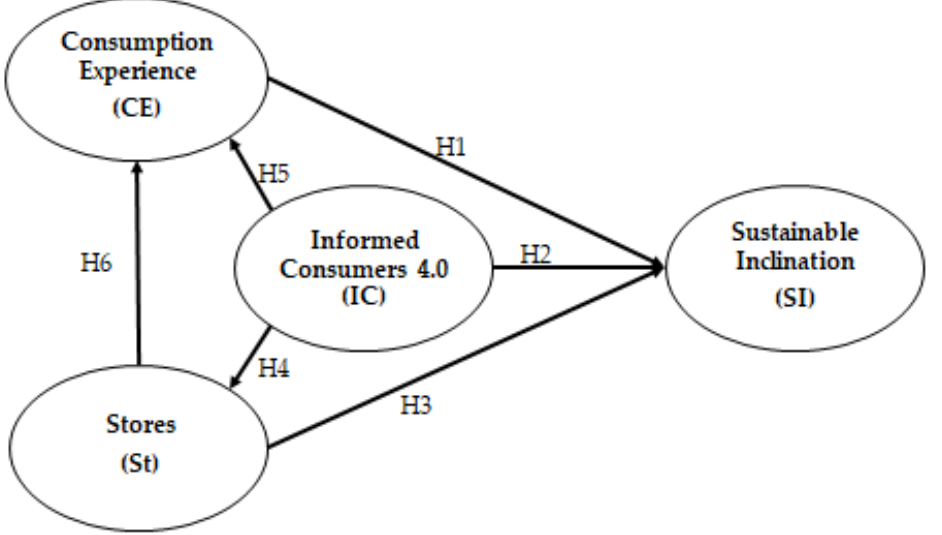
Figure 1. Conceptual model hypothesized in analysis. Source: Authors elaboration from data analysis in Smart-PLS3.